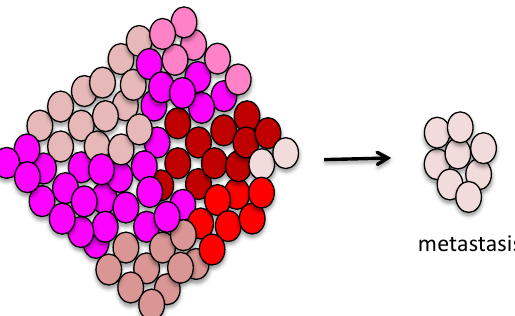
Figure 2. Schema of intratumor heterogeneity regarding metastatic potential. Tumors are composed of cell populations with various metastatic potentials. Denser red colors indicate higher metastatic potential in this schema. In the metastatic phase during cancer evolution, many different selection pressures are generated, and subclones that can adapt to the microenvironment at metastatic sites appear and metastasize. Thus, metastasizing subclones may not have the highest metastatic potential, but possibly the best adaptability to the microenvironment. When cells with low metastatic potential happen to metastasize, it may lead to oligometastatic state.